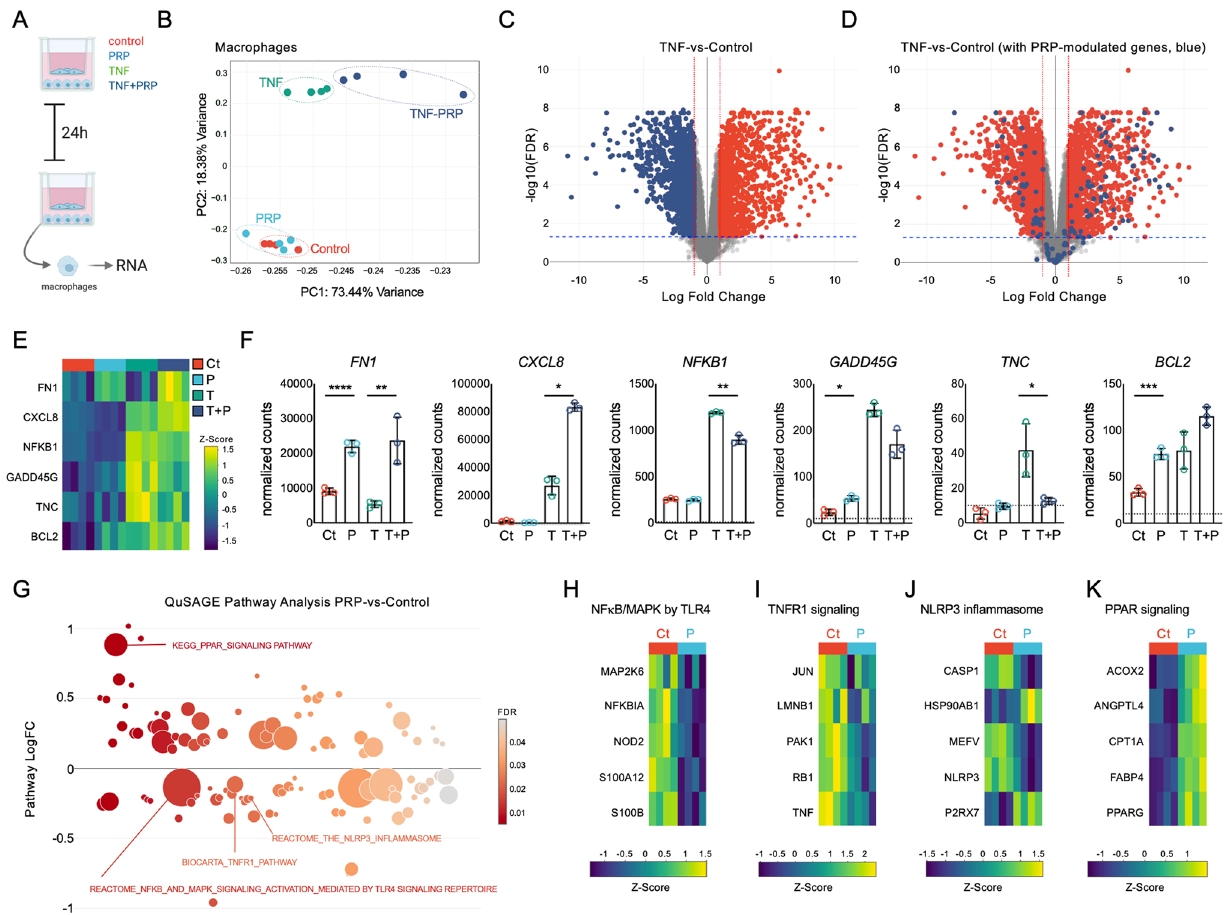
Figure 2. Transcriptomic analyses of the modulation of TNFα-driven responses by PRP in macrophages. ( A ) Schematic representation of the experimental workflow. Created with BioRender.com ( B ) Principal component analysis (PCA, using top 1,000 genes) of RNA-seq data from macrophages left untreated, or treated with TNFα and PRP, alone or combined, for 24 h. RNA-seq analysis is based on 4 independent coculture experiments, with macrophages isolated from 4 different tissue donors and PRP prepared from 4 different subjects. ( C ) Volcano plot of differentially expressed genes comparing TNFα-treated macrophages to untreated controls. Colored dots correspond to genes with significant changes greater than 1 log2-fold expression change (FDR < 0.05, LogFC > 1). Red indicates increased expression and blue indicates decreased expression after TNFα treatment. ( D ) Volcano plot representing PRP-induced changes in macrophages co-treated with TNFα + PRP. Red dots represent differentially expressed genes (DEGs) induced by TNFα relative to untreated controls, and blue dots represent PRP-induced changes in PRP + TNFα treated cells relative to TNFα-treated macrophages (FDR < 0.05, LogFC > 1). ( E ) Heatmap representation of selected DEGs by RNA-seq, and ( F ) NanoString analyses showing the normalized counts of these same selected genes, confirming changes in the control (Ct), PRP- (P), TNFα- (T) and PRP + TNFα-treated (P + T) macrophages. Dotted lines indicate background signal. * p < 0.05, ** p < 0.01, *** p < 0.001, **** p < 0.0001 by t -test, calculated using ratio data and the nSolver analysis software. NanoString data is represented as the mean ± S.D (error bars) normalized counts of 3 independent coculture experiments, using macrophages isolated from 3 different tissue donors and PRP prepared from 3 different subjects. Graphs were created with GraphPad Prism 8. ( G ) Representation of the QuSAGE pathway analyses in PRP-treated macrophages relative to untreated controls, showing functional pathways differentially expressed in PRP-treated cells (FDR < 0.05). Heatmap representation of representative genes associated with the ( H ) NF-κB/MAPK, ( I ) TNFR1, ( J ) NLRP3 inflammasome, and ( K ) PPAR signaling pathways. Data was z-score